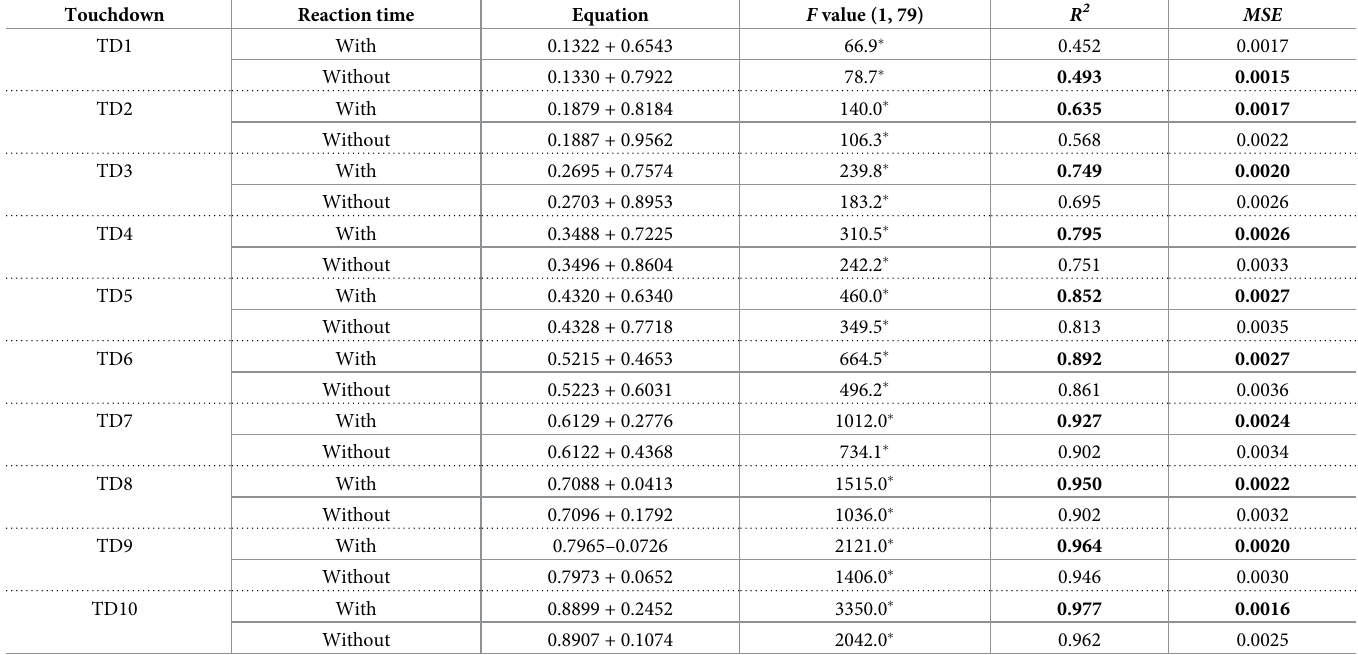
Table 2. Comparison of regression equations with and without reaction